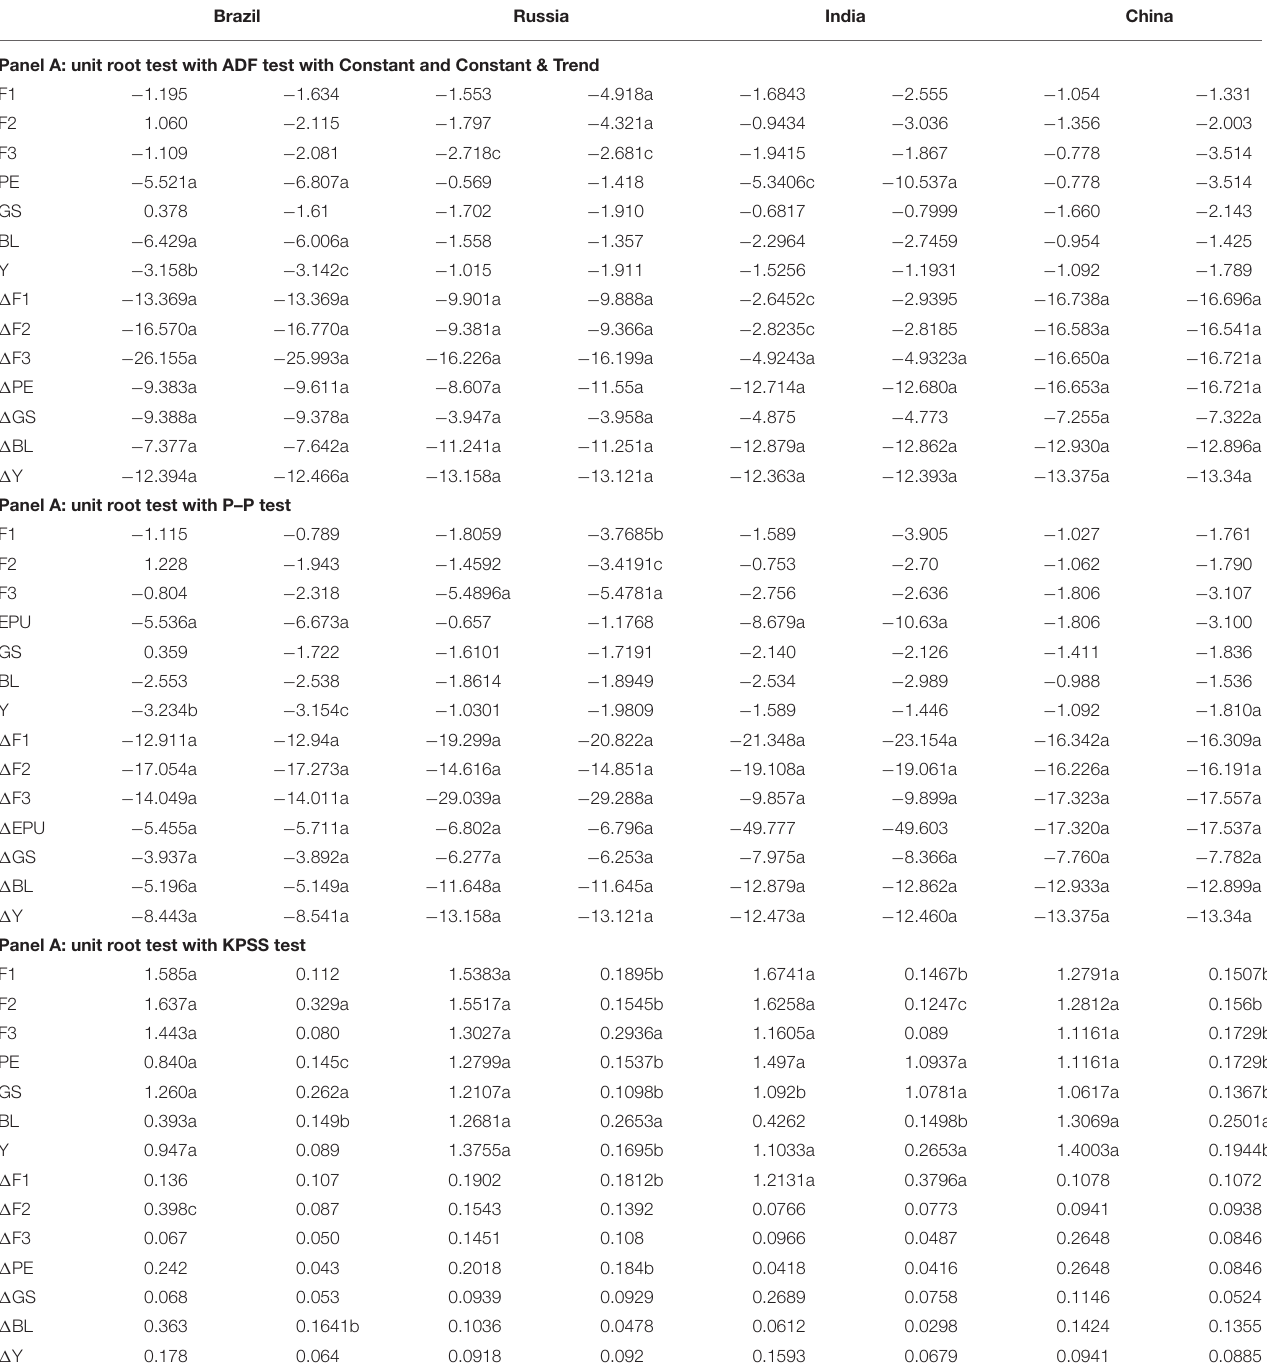
TABLE 1 | Results of unit root